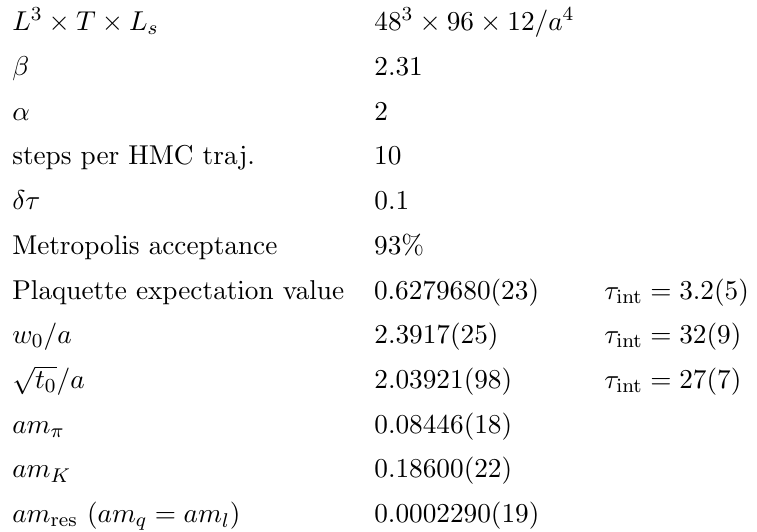
Table 10 . Basic properties of the F1